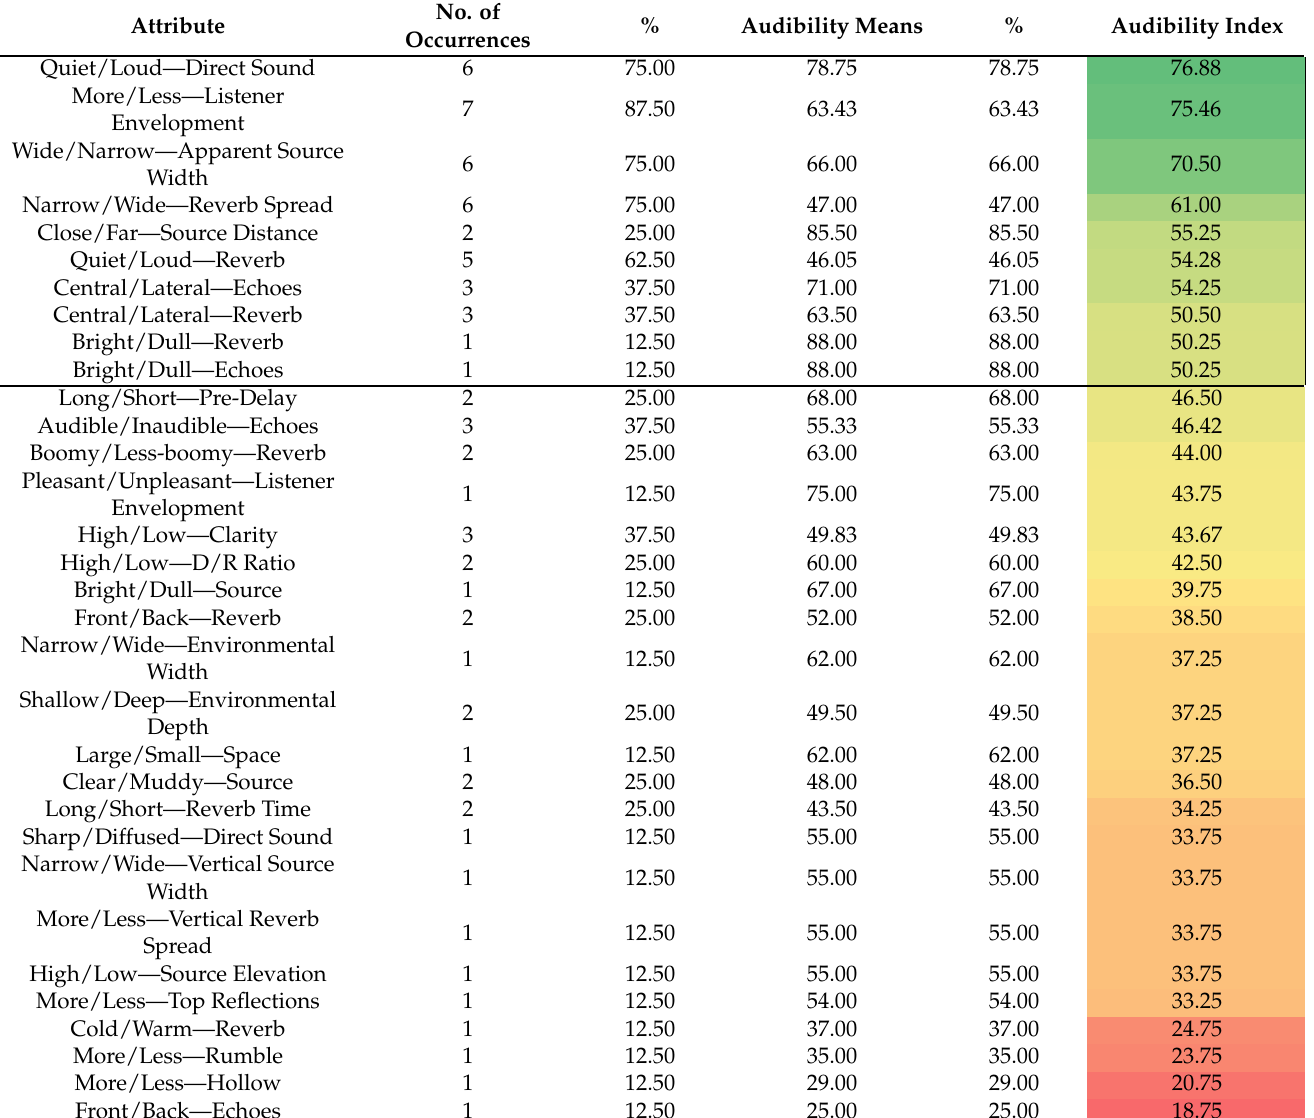
Table 4. Most salient attributes based on audibility